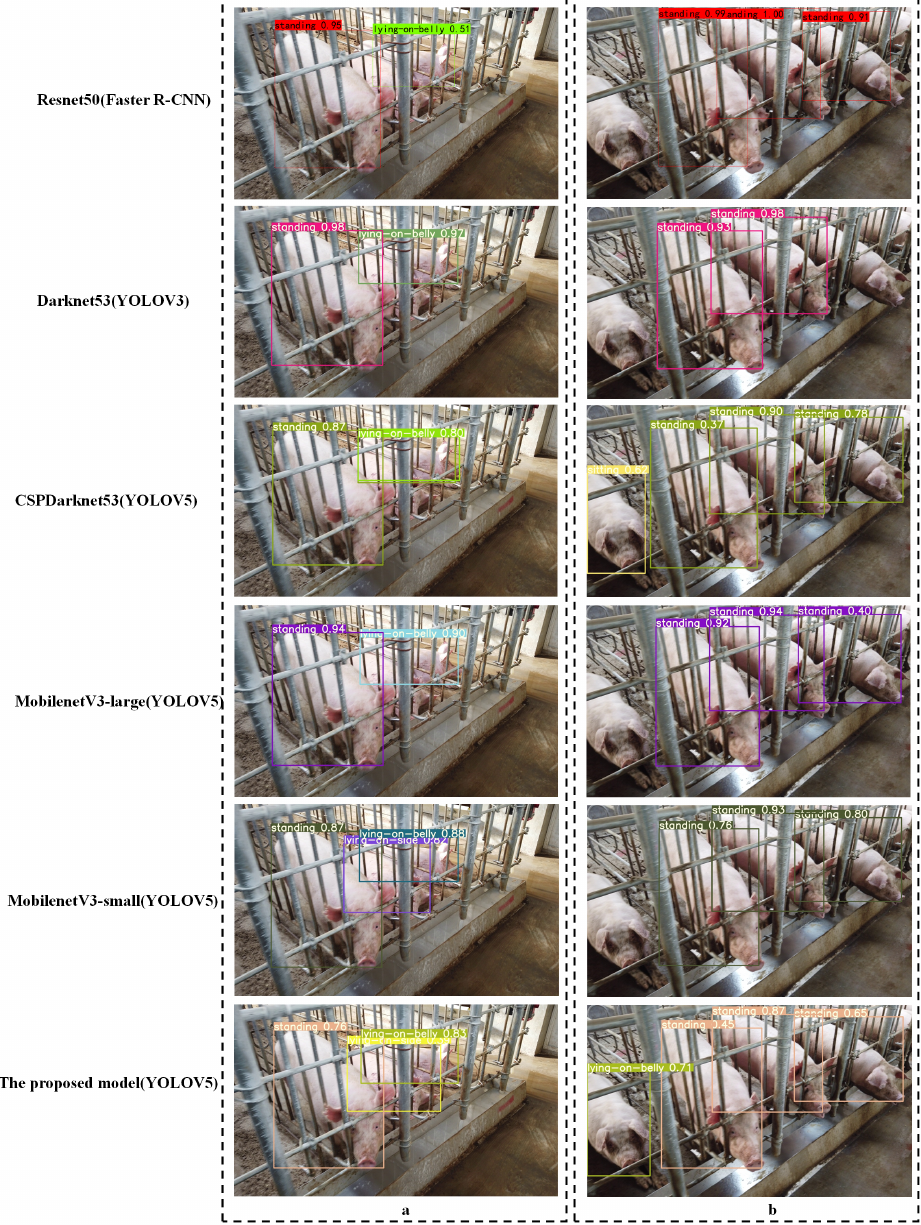
Figure 10. Examples of sow postures data set for a restricted pen. ( a ) example of missed inspections; ( b ) of error